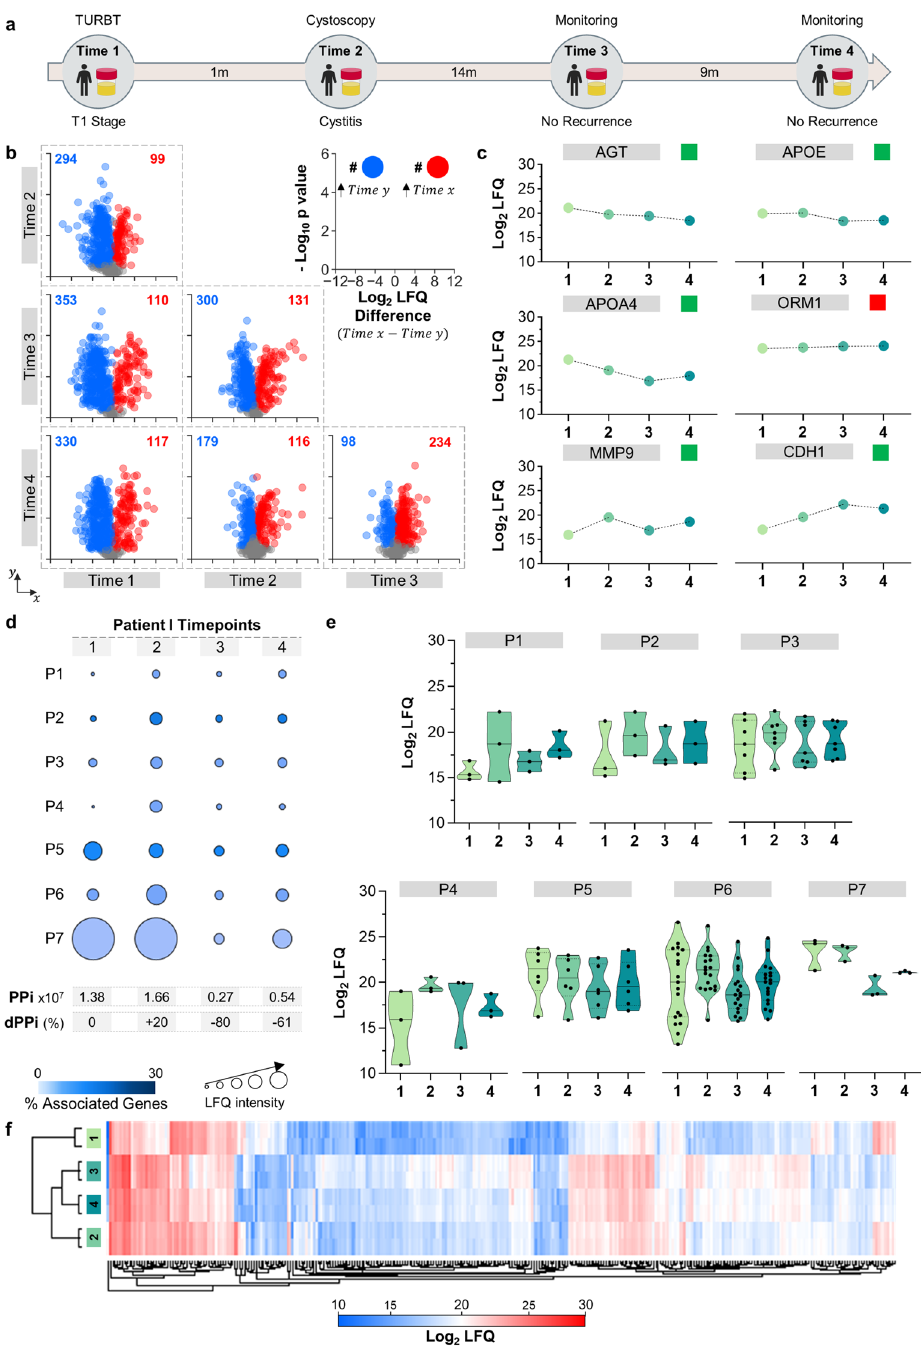
Fig. 2 Longitudinal analysis of the urinary proteome of patient I. a Timeline of the disease course in Patient I shows the intervals in months (m) between medical interventions and urine timepoint 1 – 4. TURBT: transurethral resection of bladder tumour; Re-TURBT: repeated transurethral resection of bladder tumour. b Volcano plot matrix showing proteome changes in the urine samples at time points 1 – 4. The dots represent the proteins that showed a statistically signi fi cant increase (red), decrease (blue) or nonstatistically signi fi cant changes (grey) according to the Student ’ s t test (FDR 0.05 and S0 of 0.1). c Variation in the following known protein biomarkers for bladder cancer: angiotensinogen (AGT) 35 , apolipoprotein E (APOE) 36 , matrix metalloproteinase-9 (MMP9) 37 , apolipoprotein A-IV (APOA4) 29 , alpha-1-acid glycoprotein 1 (ORM1) 38 and cadherin-1 (CDH1) 30, 31 . The green and red squares indicate whether the variation in the urine of Patient I matched or not, respectively, with trends reported for each marker in the literature. Dots represent the average of two biological samples with two technical replicates each. d Personal pathway index (PPi) at each time point and estimated differential PPI (dPPi) were calculated as explained in the text. P1: interleukin-12-mediated signalling pathway; P2: endodermal cell differentiation; P3, proteoglycan binding; Pa: peroxidase activity; P5: complement cascade; P6: humoral immune response; P7: oncogenic MAPK signalling. e Distribution and density variation protein LFQ values (including two biological replicates) at each timepoint point for each pathway assessed. Continuous bar in the middle represents the median. The thin discontinuous line represents the quartile lines. f Hierarchical clustering of the three urinary proteomes of Patient I. Protein LFQ values were used to perform the cluster analysis (with average linkage, no constraint, preprocessing with k -means and Euclidean distance). COMMUNICATIONS MEDICINE| (2023) 3:8 |https://doi.org/10.1038/s43856-023-00238-4|www.nature.com/commsmed